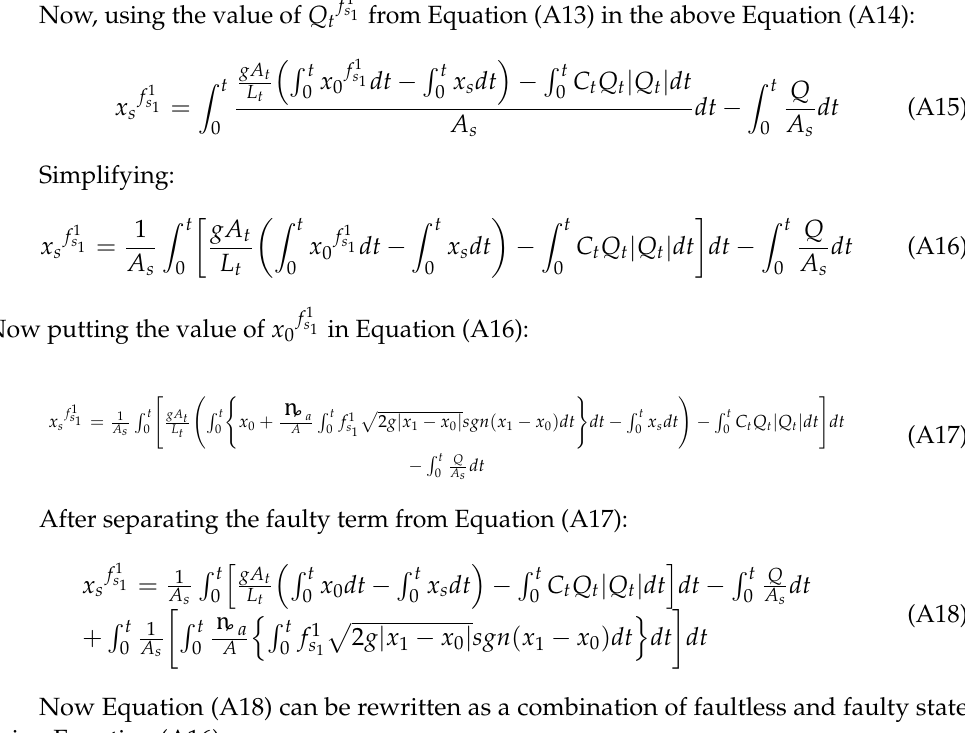
Figure 1. Three-pond hydraulic system.